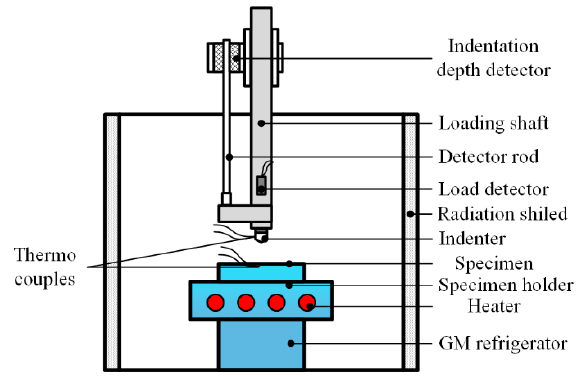
Figure 8. Schematic diagram of indentation apparatus with Gifford-McMahon (GM) refrigerator.